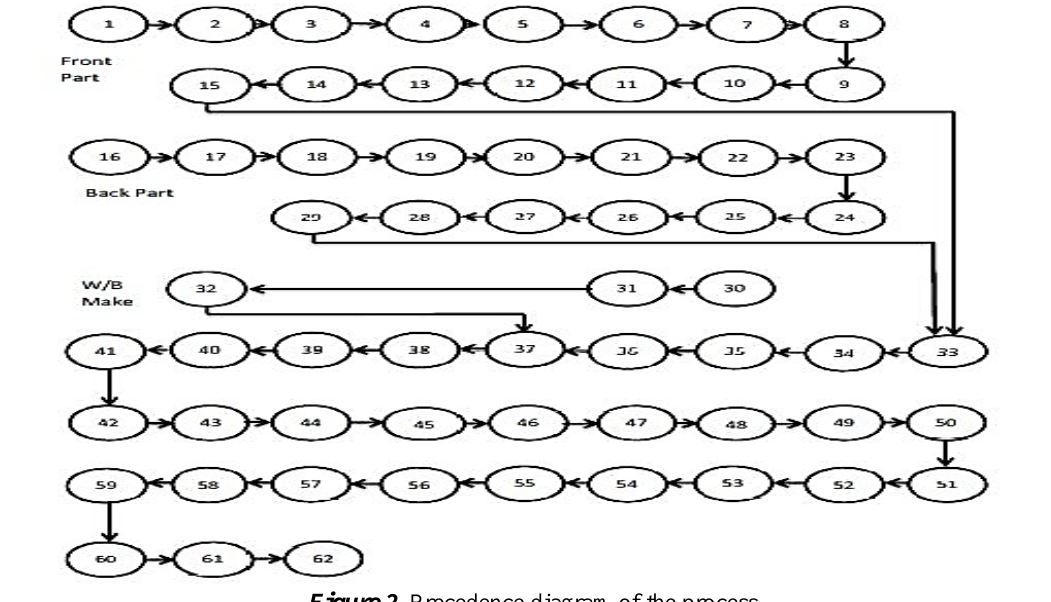
Figure 2. Precedence diagram of the